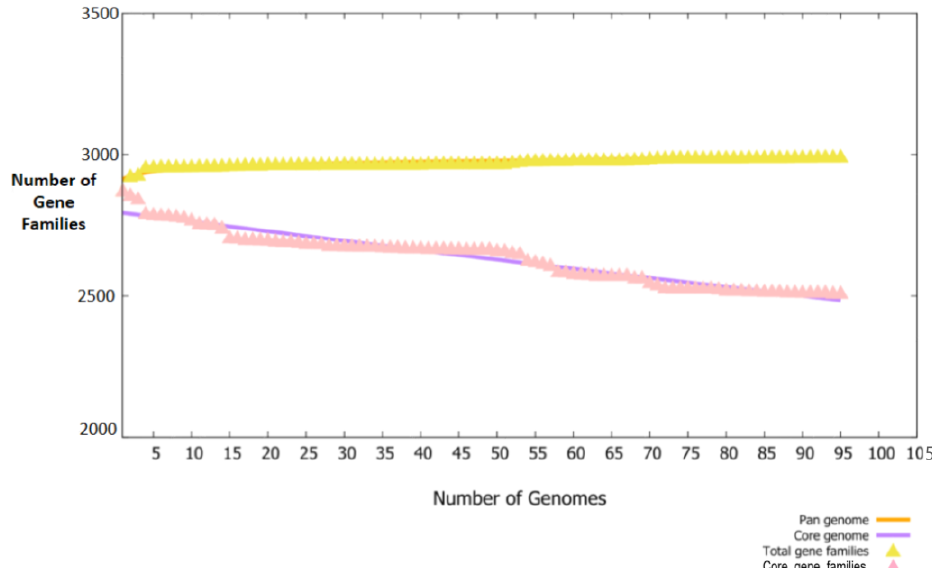
Figure 2. Shortlisted proteins in each step of subtractive proteomics filter.